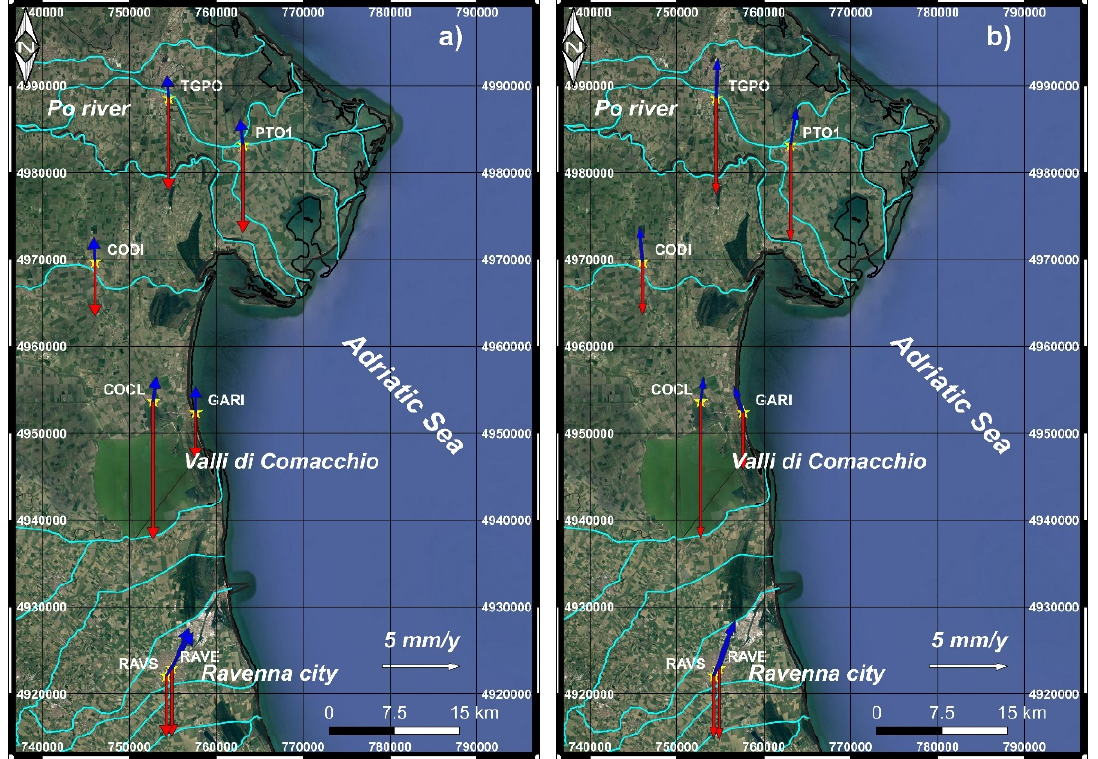
Figure 4. Vertical (red arrows) and horizontal (blue arrows) GNSS kinematic patterns in the study area, ( a ) considering the entire time interval, ( b ) data acquired after 2016. Yellow stars indicate positions of the GNSS sites reported in Table 1.